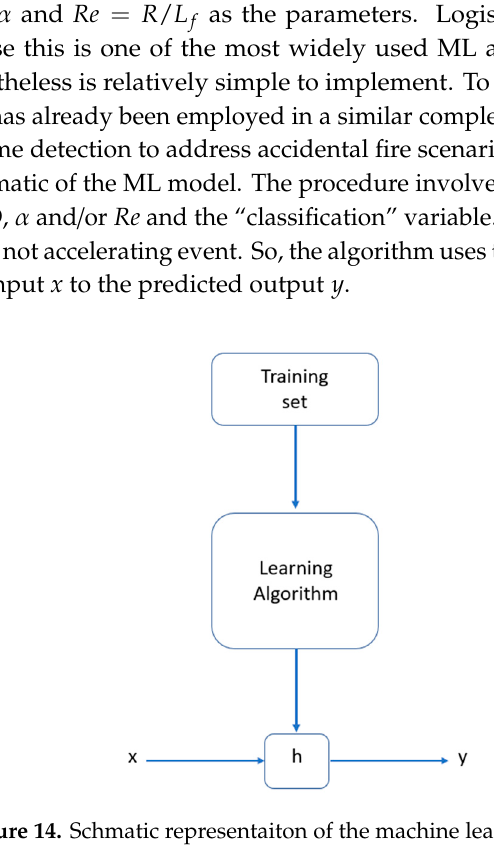
(19) Figure 15. The sigmoid function g ( z ) of Equation (19). As a result, the function ℎ (cid:2968) (𝑥) describes the probability of 𝑦 = 1 for a given 𝑥 value. As such, if ℎ (cid:2968) (𝑥) ≥ 0.5 then 𝑦 = 1 , and 𝑦 = 0 for ℎ (cid:2968) (𝑥) < 0.5 . From the simulation results, the cases undergoing acceleration are classified as 1, and the cases with only quasi-steady propagation are 0. The training sets consist of the input variable 𝑥(Θ, α, 𝑅𝑒) and 𝑦 . The results obtained for the hypothesis function have been subsequently used to classify and develop the regime diagrams depicted in Figures 16–17.